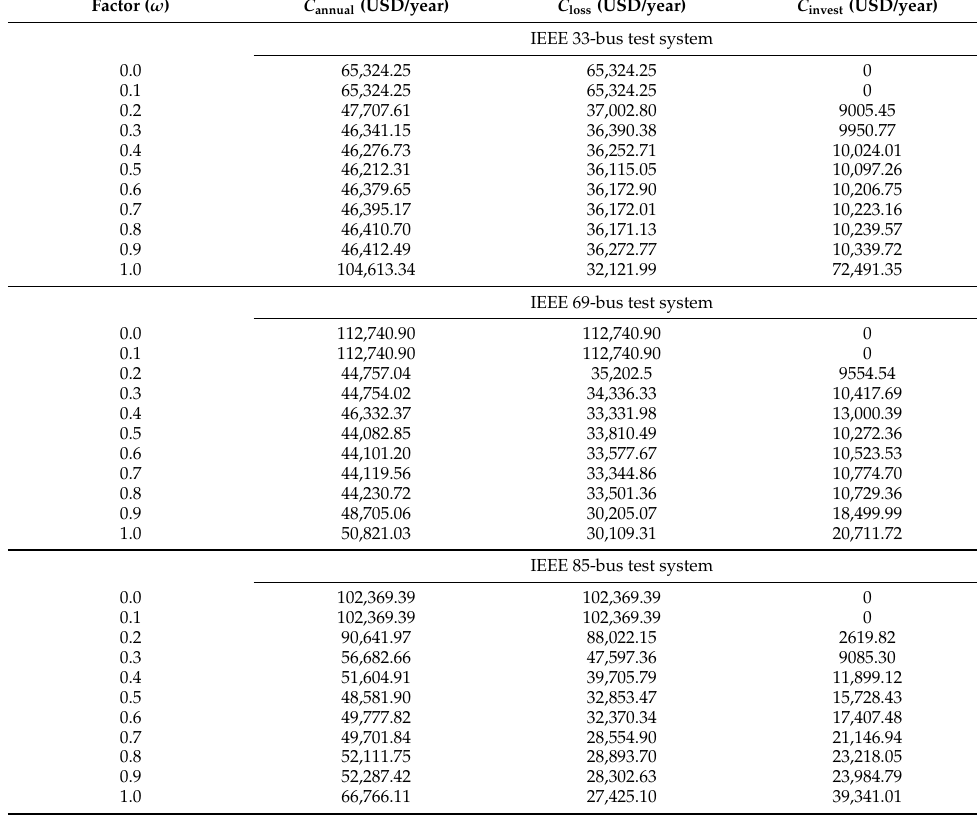
Table 5. Pareto set attained with the weight factor